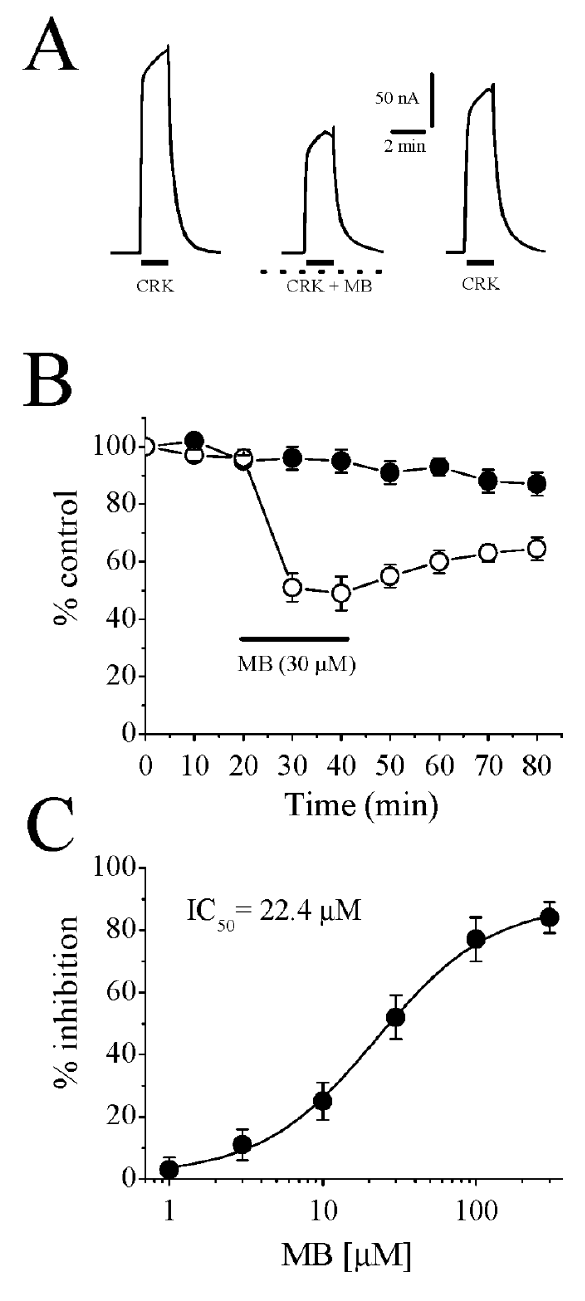
Figure 1. Cromakalim-induced outward currents are inhibited by MB in follicular cells of Xenopus oocytes. ( A ) Currents activated by 100 μM cromakalim ( left ), during co-administration of cromakalim and 30 μM MB following 20 min MB preincubation ( middle ), 20 min recovery ( right ). Administration times for cromakalim are shown with solid horizontal bars. Dotted lines represent continuous MB application during recordings. ( B ) Time course of the peak cromakalim-activated currents are shown in the absence ( filled circles ) and the presence of 30 µM MB ( open circles ). Each data point indicates the normalized means and S.E.M. of five to six experiments. The horizontal bar represents the duration of MB administration. ( C ) Concentration-response curve for the inhibitory effect of MB on cromakalim (100 μM) -activated currents. Data points are shown as means ± S.E.M. ( n = 4 – 5). The curve is the best fit of the data to the logistic equation presented in the methods section. CKL: cromakalim; MB: methylene blue.